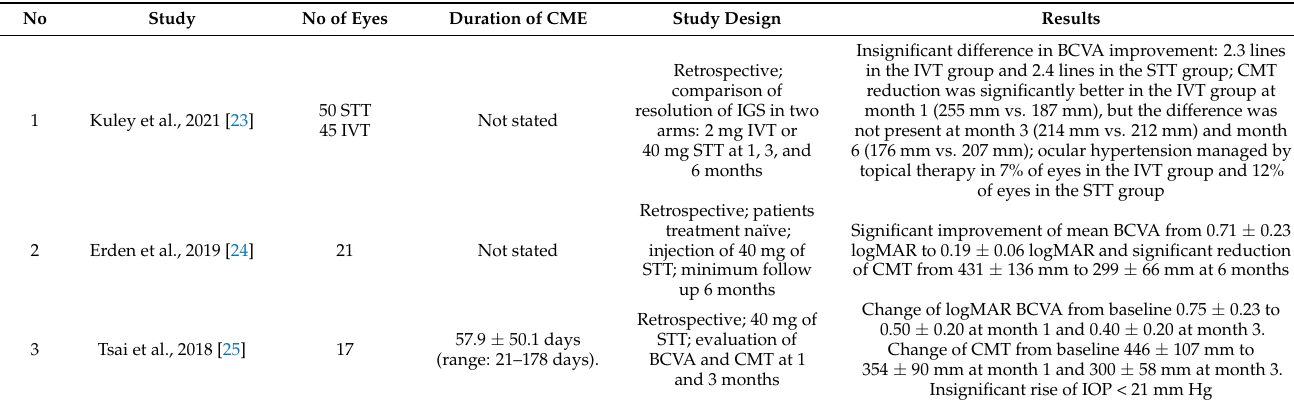
Table 4. Results of the studies analyzing the efficacy of periocular corticosteroids in the treatment of IGS that involved at least 10 cases and were published since 2000.